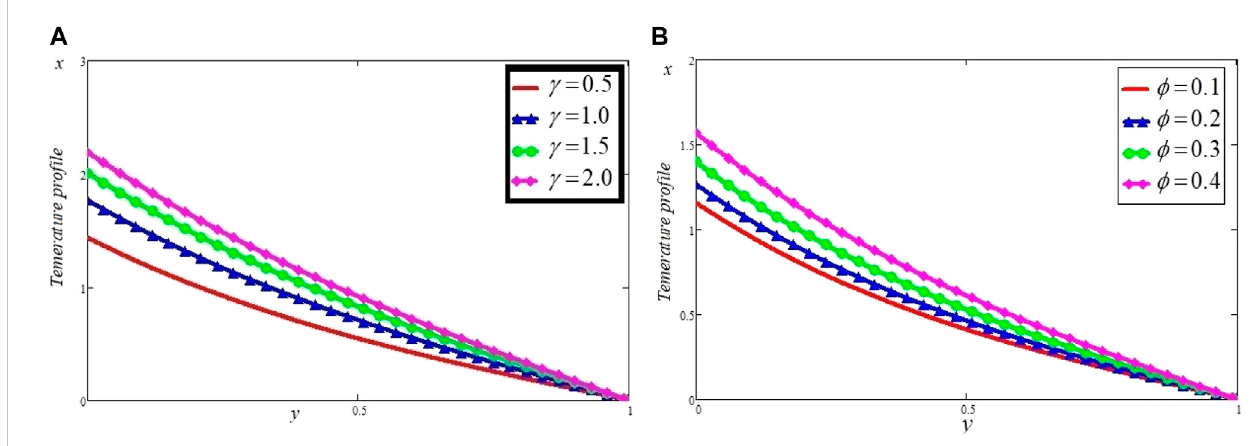
FIGURE 9 Effect of γ and ϕ on θ ( y , t ) . When When Pe (cid:2) 2 , R (cid:2) 3 ϕ (cid:2) 2 , and γ (cid:2) 2.